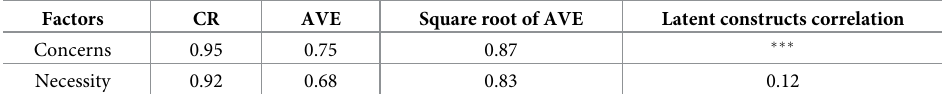
Table 4. Average Variance Extracted (AVE) and Composite Reliability (CR) for BMQ concerns and necessity